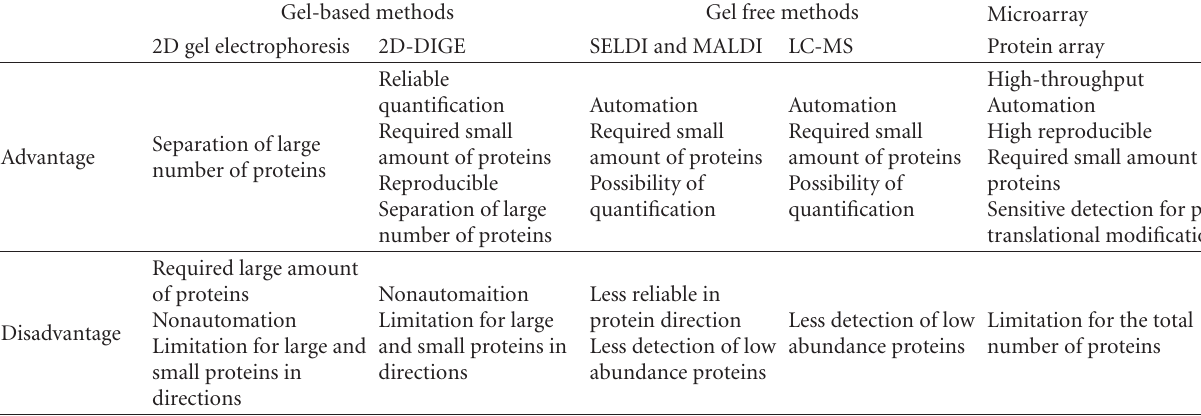
Table 2: Summary of the platforms in proteomic analysis.